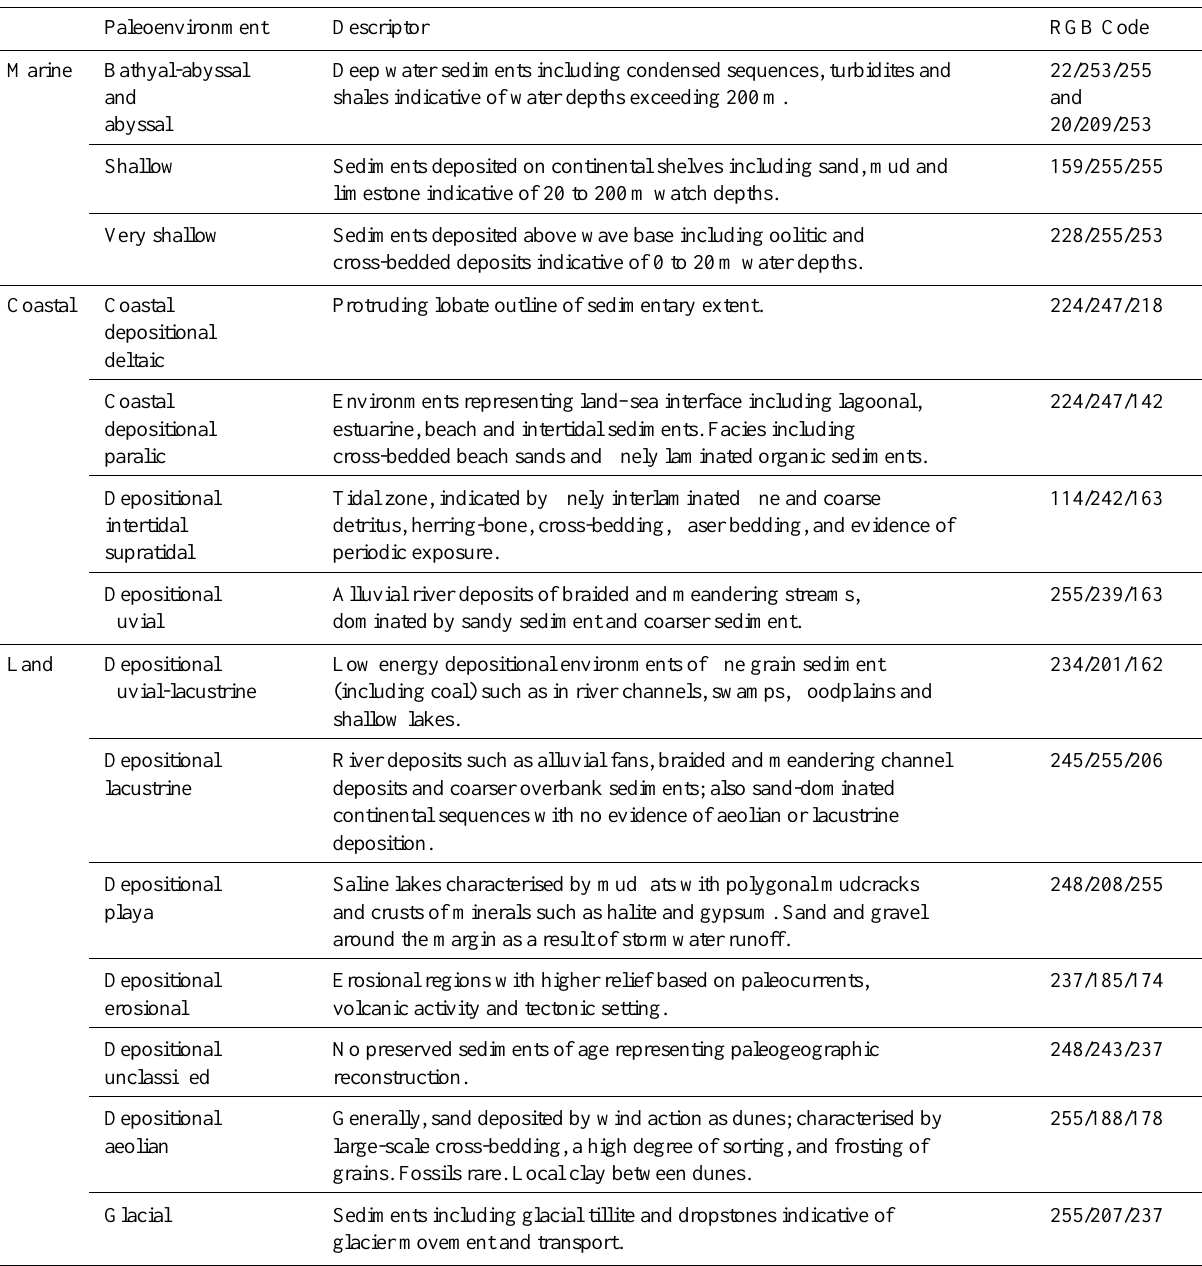
Table 1. Paleogeographic descriptors in the Palaeogeographic Atlas of Australia (Totterdell, 2002) and colour (RGB) values representing each